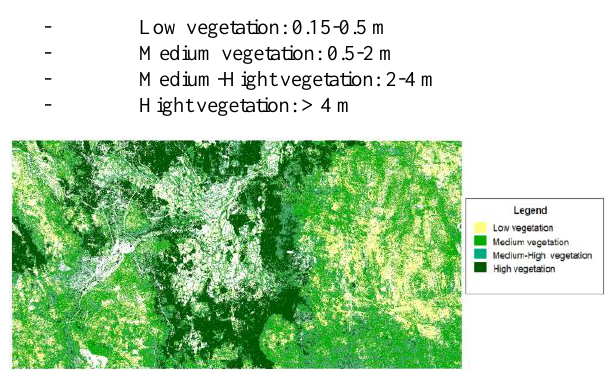
Figure 4. Vegetation stratified by height